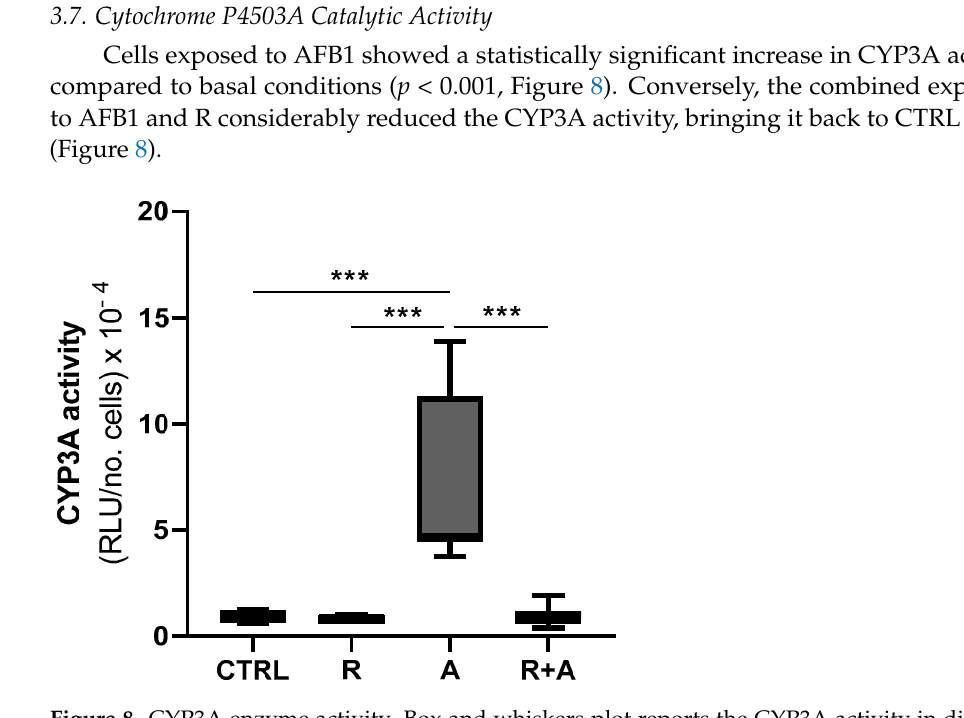
Figure 8. CYP3A enzyme activity. Box and whiskers plot reports the CYP3A activity in different experimental conditions. The statistical comparisons were established between the median CYP3A activity in cells exposed to AFB1 and the CYP3A activity observed in the other experimental condi- tions. For each experimental condition, seven independent cell culture experiments were performed. Data are expressed as relative luminescence units (RLU) normalized to the total number of alive cells. CTRL condition corresponds to cells exposed to PCB126 only. R = resveratrol; A = AFB1. *** p < 0.001 (one-way ANOVA, followed by Dunnett’s multi-comparisons